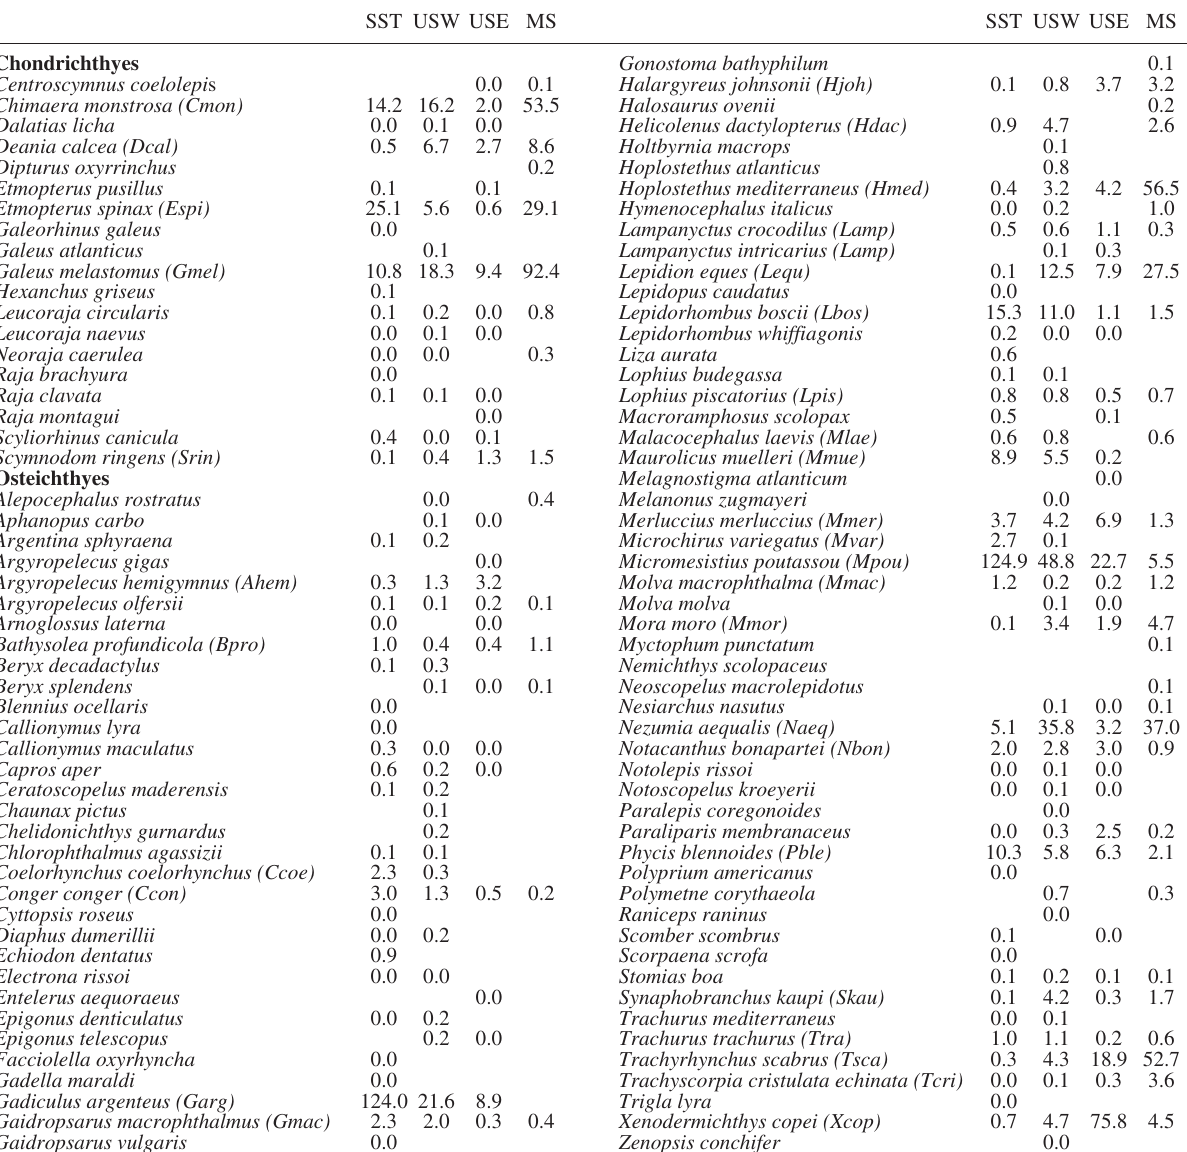
Table 1. – List of fish species identified in the area. with their density (ind. ha –1 ) in each assemblage. Species codes used in Figure 3b appear between brackets after species name. in those species used in RDA analysis. 0.0 mean values >0 and <0.1 SST USW USE MS SST USW USE MS